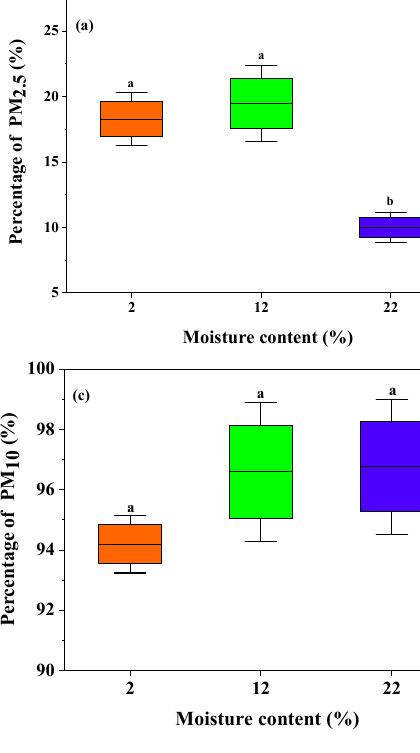
Figure 5. Comparison of the EF proportion of PM with different moisture contents: ( a ) EF proportion of PM 2.5 ; ( b ) EF proportion of PM 4 ; ( c ) EF proportion of PM 10. The letters a and b mean that if there is any same letter in the figure, the difference is not significant.